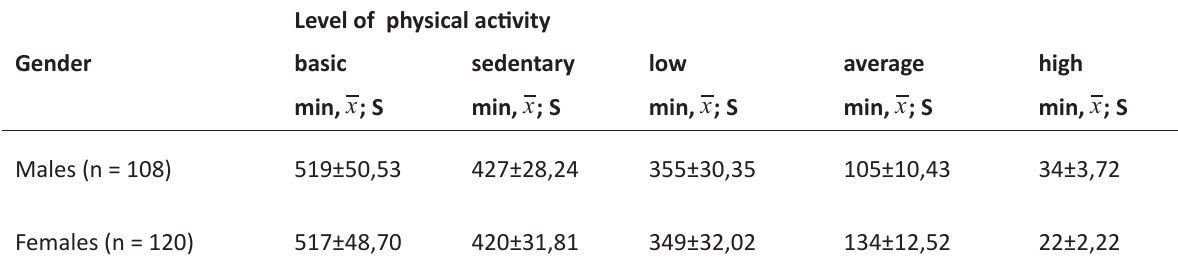
Table 1. Indicators of students’ physical activity level